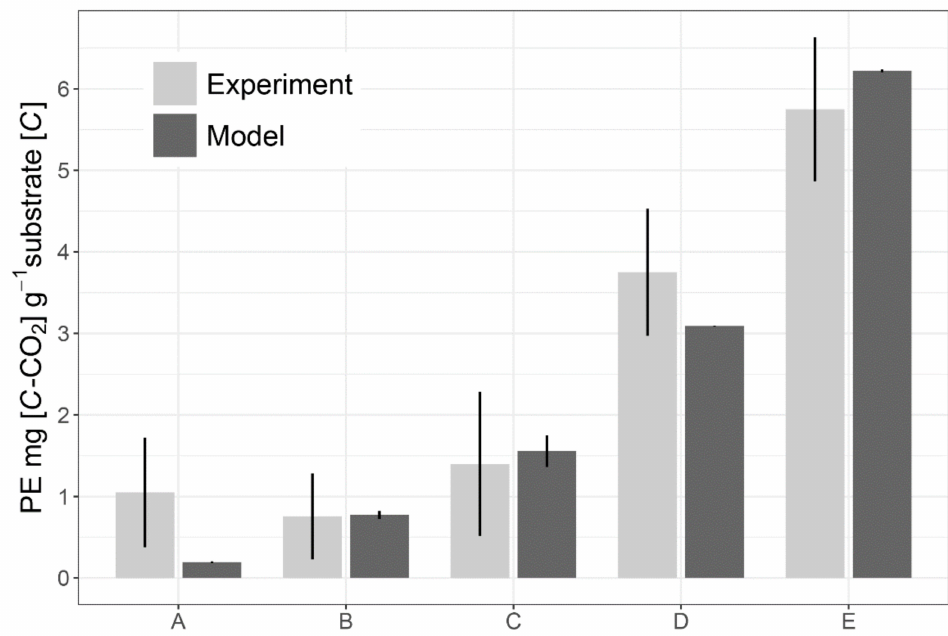
Figure 2. Comparison of the results of the priming effect (PE) measured in the laboratory experiment for subtropical forest soil [4] with simulated in the model and calculated as a sum of microbial respiration and rhizosphere SOM mineralization at nitrogen mining ( ∆ R MO + ∆ R + initial data on C and N inputs with root exudates (RE) for model runs were identical to the data used in the experiment and imitated the following RE rates and their C:N: A—3 mg [C] g –1 soil, C:N = 20; B—12 mg [C] g –1 soil, C:N = 20; C—12 mg [C] g –1 soil, C:N = 80; D—48 mg [C] g –1 soil, C:N = 20; E—48 mg [C] g –1 soil, C:N = 80. The bars represent standard deviation. Simulation span is 30